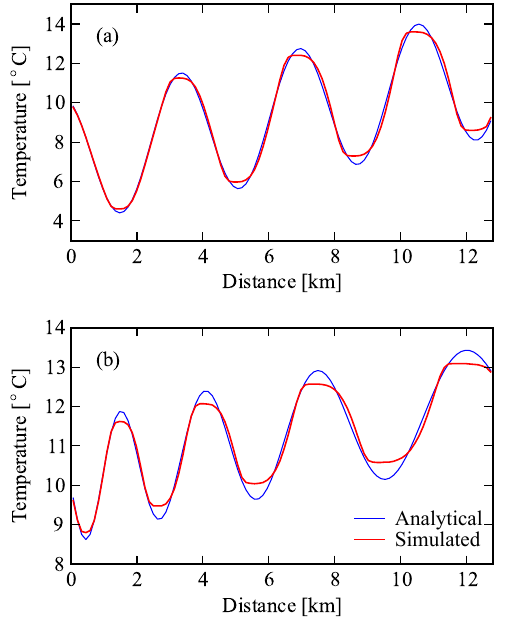
Figure B2. Stream temperature profile at the end of the simulation (8h) in (a) test case 1 and (b) test case 2. The analytical temperature profiles are displayed in blue, and those simulated by the splitting scheme in